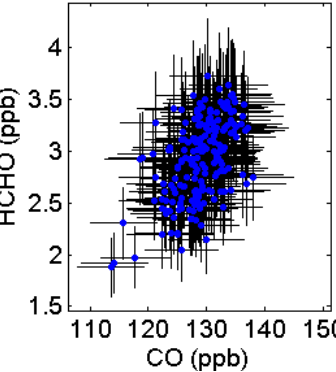
Figure 5. HCHO and CO in the mixed layer. Error bars represent instrument accuracy. There is little variation in mixed layer CO, and the correlation with HCHO is low ( r 2 = 0.29).